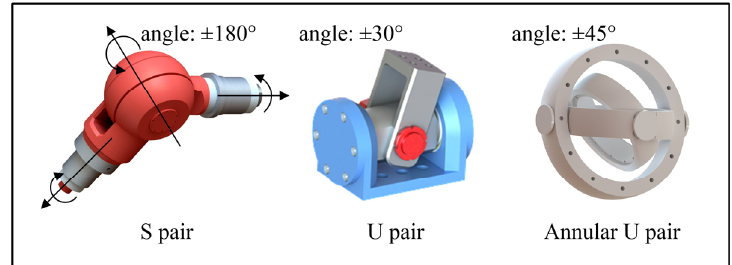
Figure 4. Joint structure.